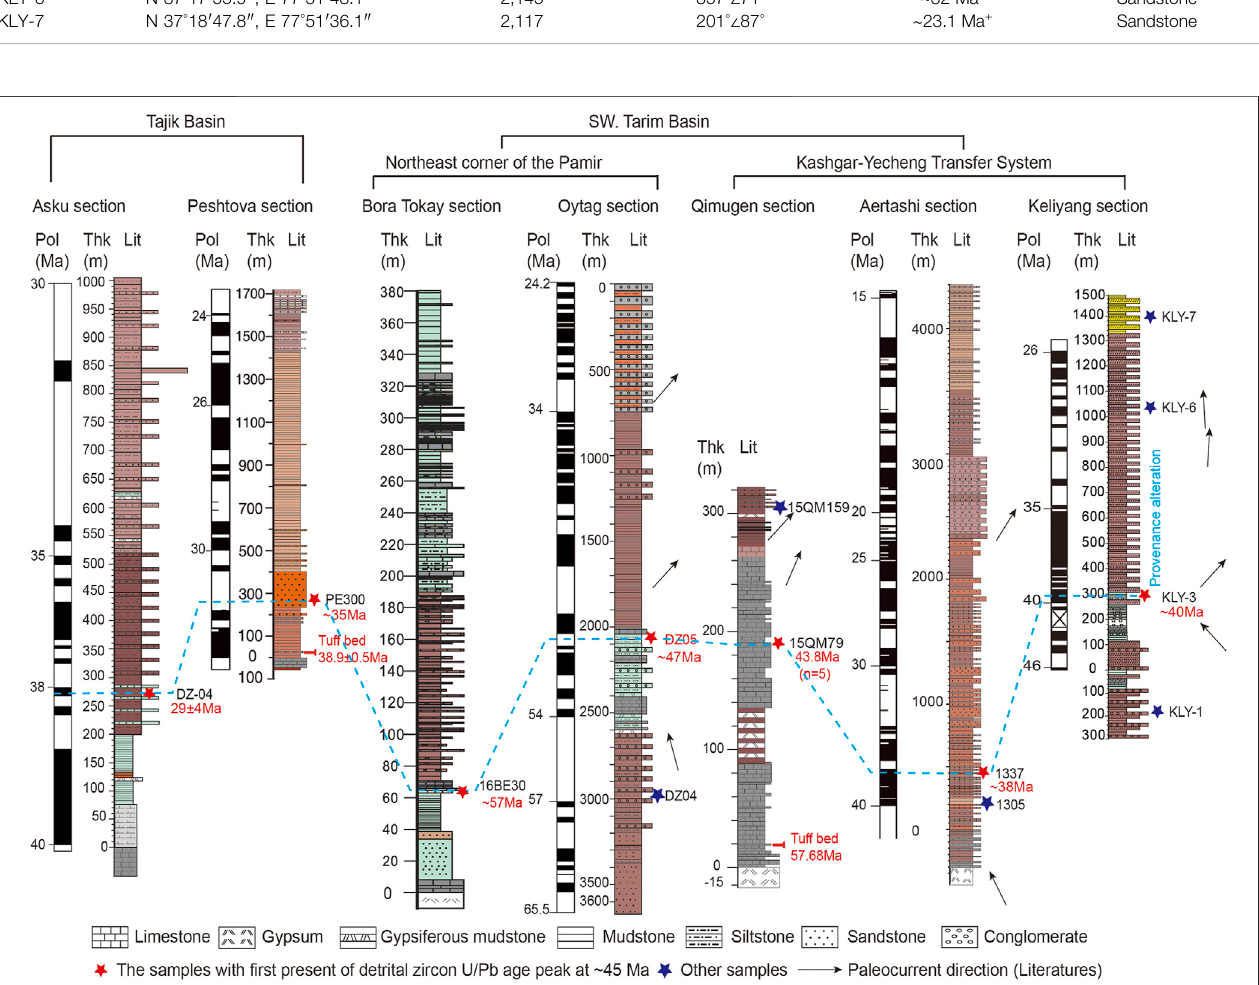
FIGURE 4 | Mesozoic-Cenozoic sedimentary provenance study sections in the Tajik and Tarim basins, including the Asku (Sun et al., 2020), Pehtova (Wang et al., 2019), Bero Tokay (Zhang et al., 2019), Oytag (Sun et al., 2016b; Zhang et al., 2019), Qimugen (Zhang et al., 2019), Aertashi (Blayney et al., 2016) and Keliyang (this study) sections. Mesozoic-Cenozoic paleocurrents are based on previous studies in the Akqiy (Zhang et al., 2019), Oytag (Bershaw et al., 2012; Sun et al., 2016b), Qimugen (Cao et al., 2014), Aertashi (Sobel, 1999; Zheng et al., 2015) and Keliyang (Li et al., 2021) sections. The blue dashed line shows the minimum age of sedimentary provenance changes in each section from the Tajik and Tarim basins. Pol (cid:1) Observed Polarity; Thk (cid:1) Thickness; Lit (cid:1) Lithology.